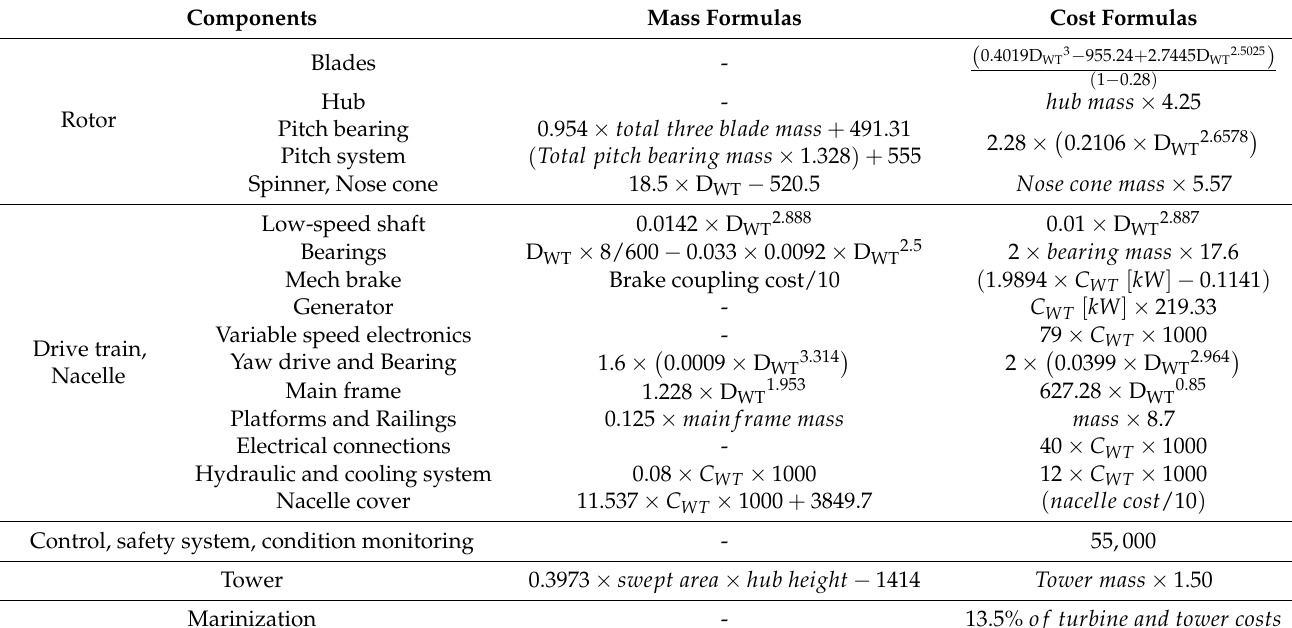
Table 5. Cost formulas for turbine capital cost (TCC) of the FOWT [32].